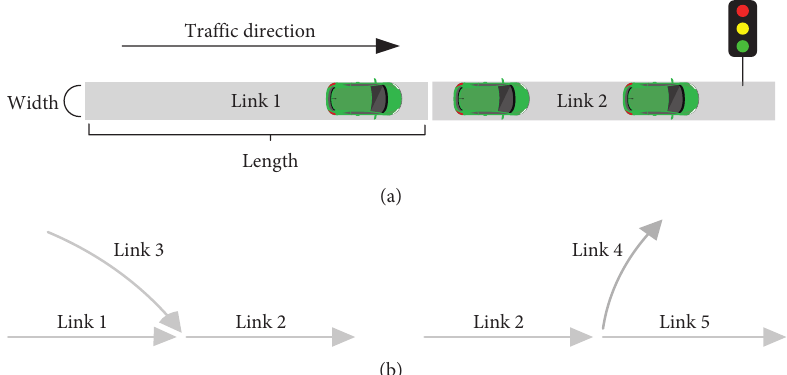
Figure 2: Main spatial information of roads. (a) The attribute information of links. (b) The upstream and downstream relationship of road segments.